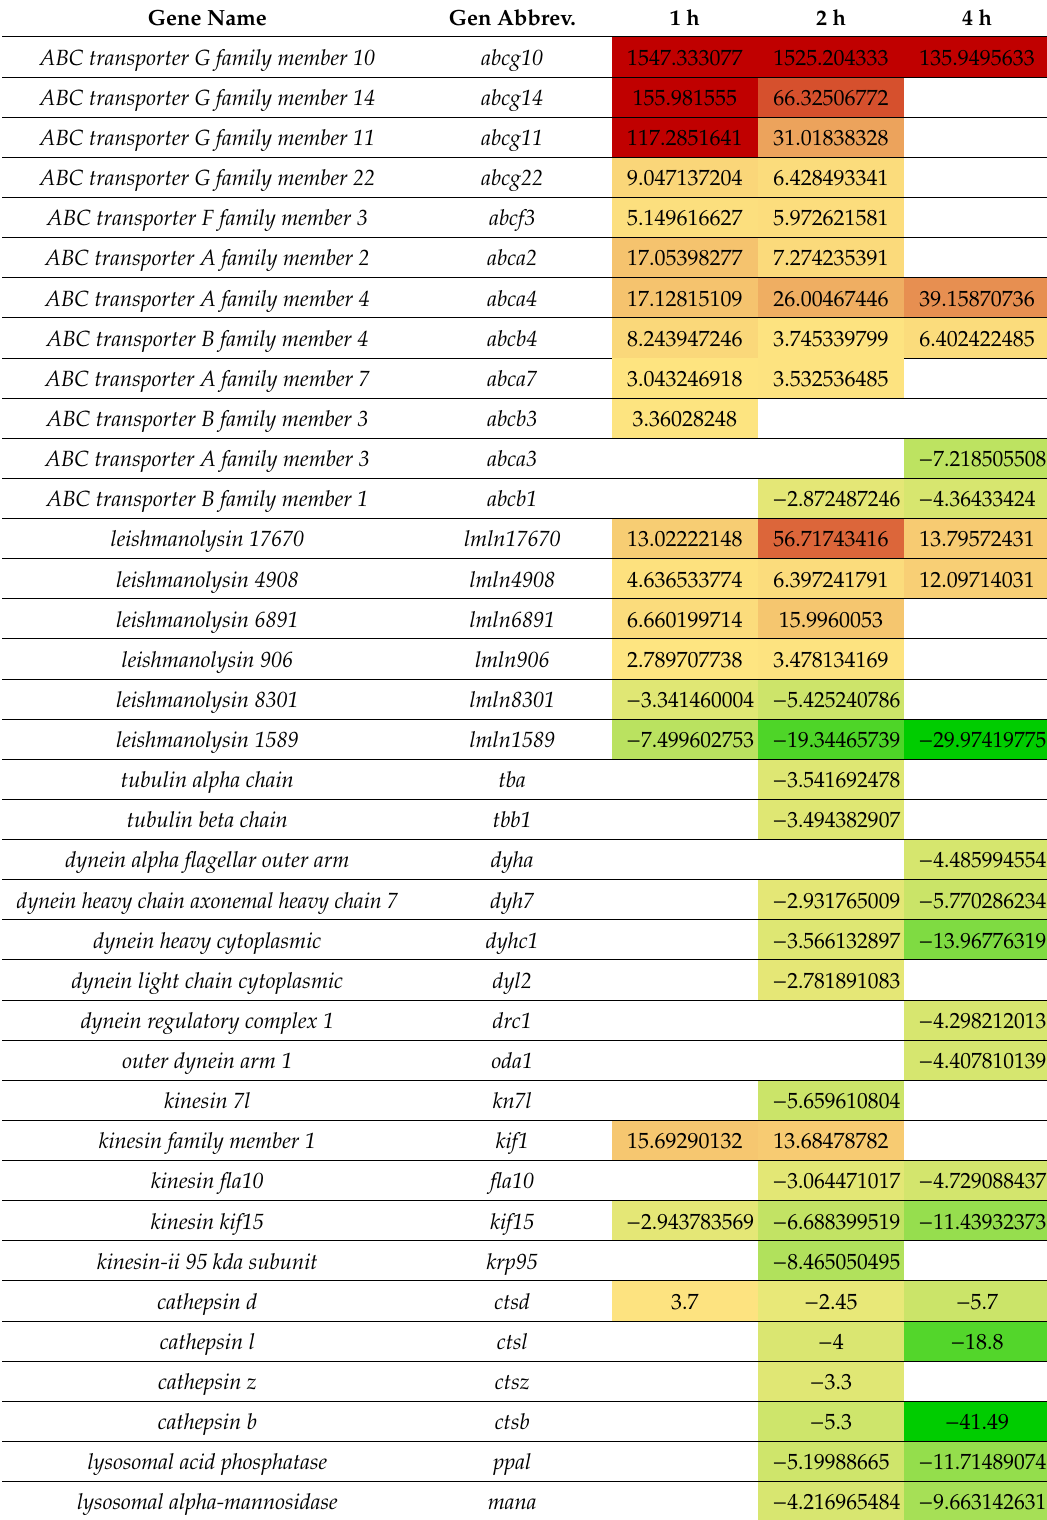
Table 1. Heat map showing a group of di ff erentially expressed (DE) genes in P. dicentrarchi, including ABC transporters, leishmanolysins and genes related to microtubules and to lysosomes, at 1, 2 and 4 hpi. Results are expressed as mean expression ratios of groups 1, 2 and 4 hpi vs. 0 h. Red indicates increased gene expression levels; green indicates decreased